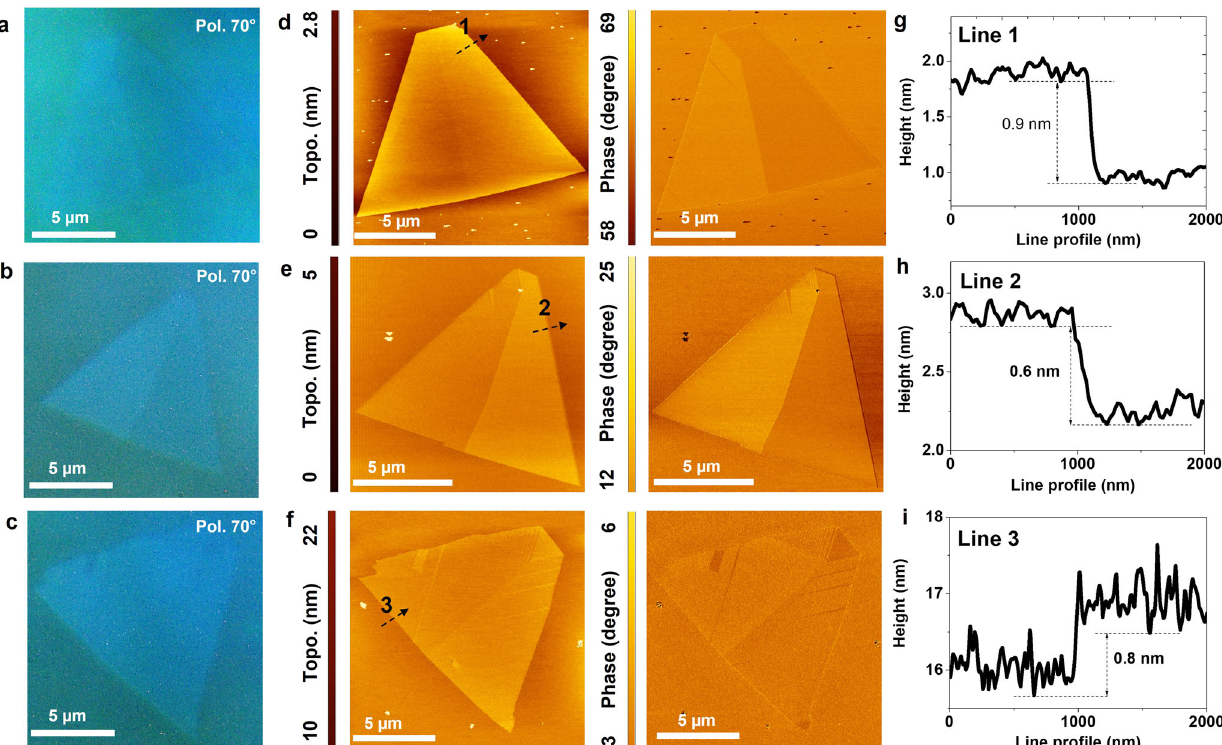
Fig. 3 DFM topography and phase images of CVD-grown 2D ReS 2 with different cooling rates. a – c Polarized OM images of 1L-ReS 2 /mica synthesized with the slow-cooling rate (5 °C min − 1 ), normal slow-cooling rate (25 °C min − 1 ), and fast-cooling rate (120 °C min − 1 ), respectively. d – f DFM topography image and phase image corresponding to samples in a – c , respectively. g – i Line pro fi les corresponding to dash black lines in d – f .